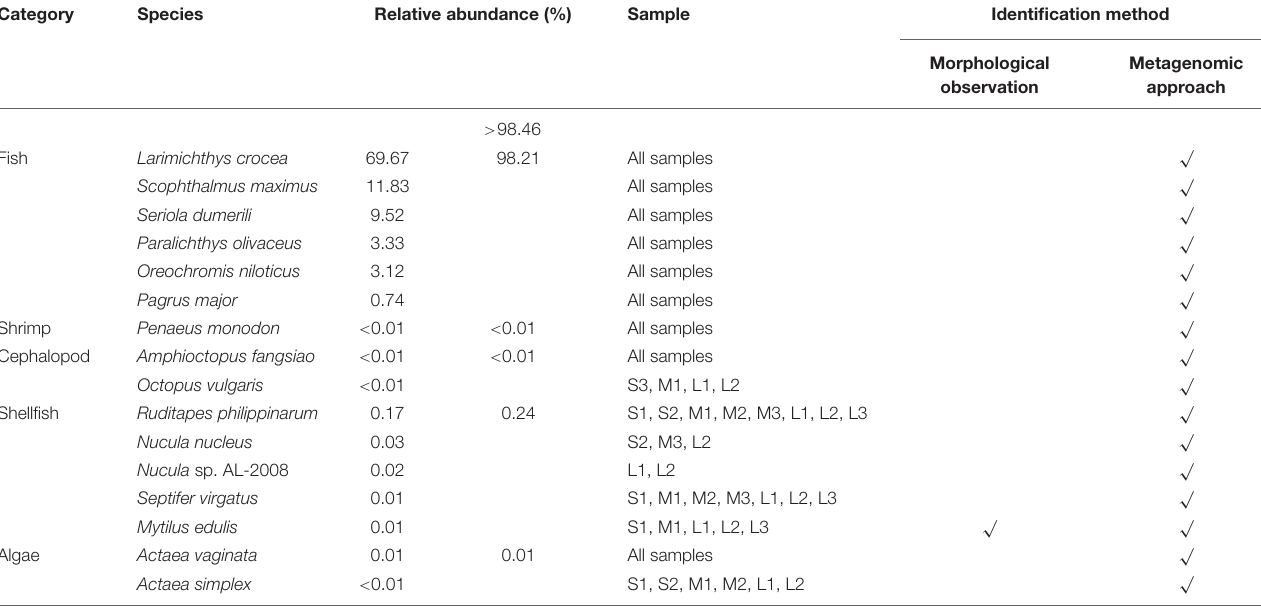
TABLE 2 | The main potential dietary compositions of yellowfin sea bream in Daya Bay. Category Species Relative abundance